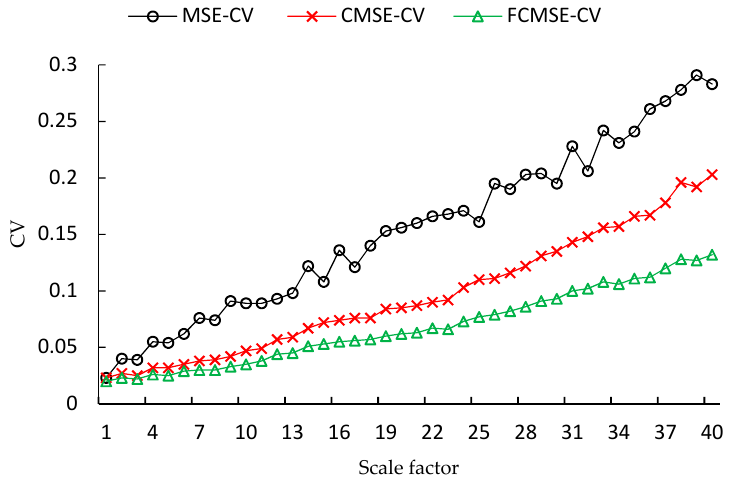
Figure 8. CVs of white noise with length 1000.